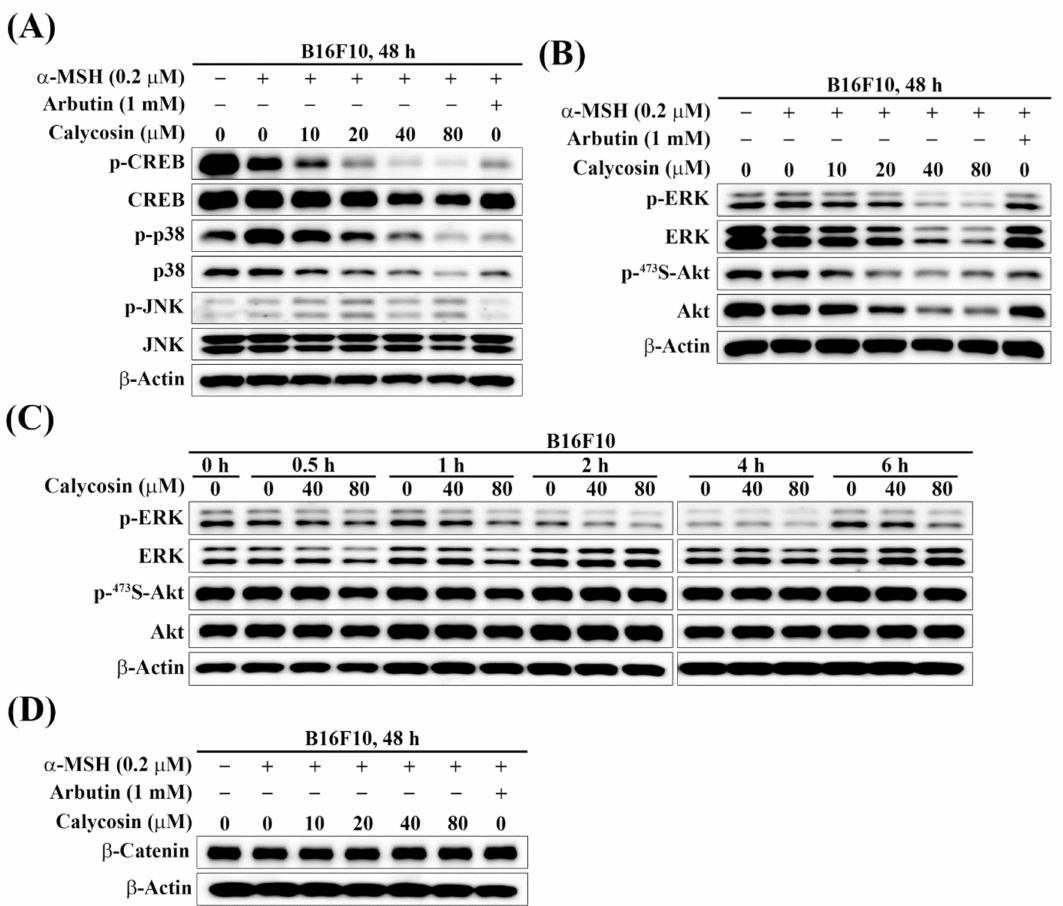
Figure 4. Effect of calycosin on the melanogenesis-related protein expression levels in B16F10 cells. Western blot analyses of the dose-dependent effect of calycosin on the expressions and phosphoryla- tions of ( A ) CREB, p38, JNK, and ( B ) ERK and Akt in B16F10 cells treated with 0.2 µ M α -MSH and indicated concentrations of calycosin for 48 h. ( C ) Western blot analyses of the time-dependent effect of calycosin on the expressions and phosphorylations of ERK and Akt in B16F10 cells treated with 40 µ M or 80 µ M calycosin for indicated time periods. ( D ) Western blot analysis of the dose-dependent effect of calycosin on the expression level of β -Catenin in B16F10 cells treated with 0.2 µ M α -MSH and indicated concentrations of calycosin for 48